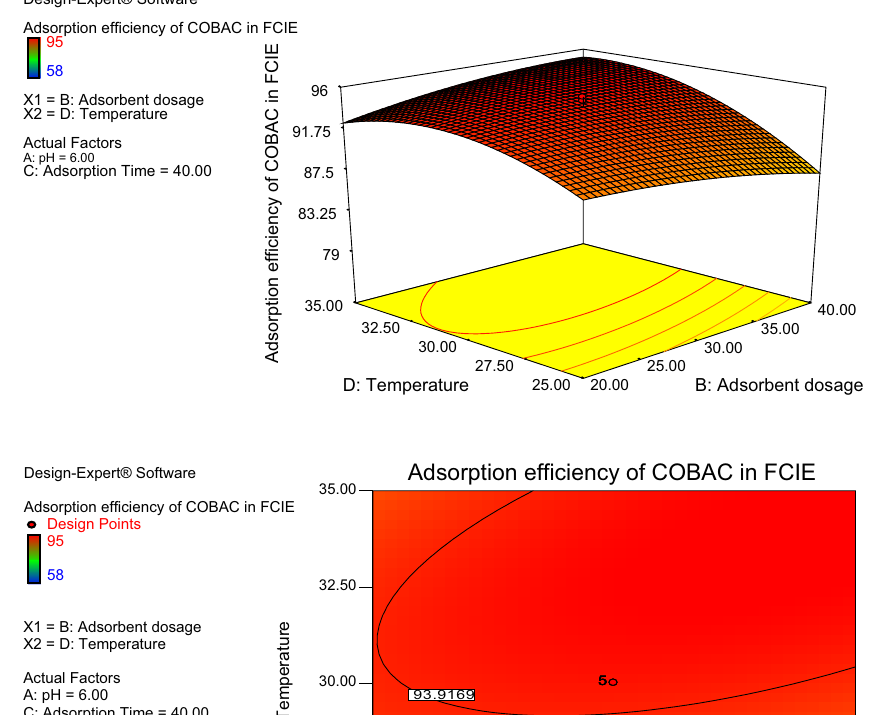
Fig. 9 3D plot showing the